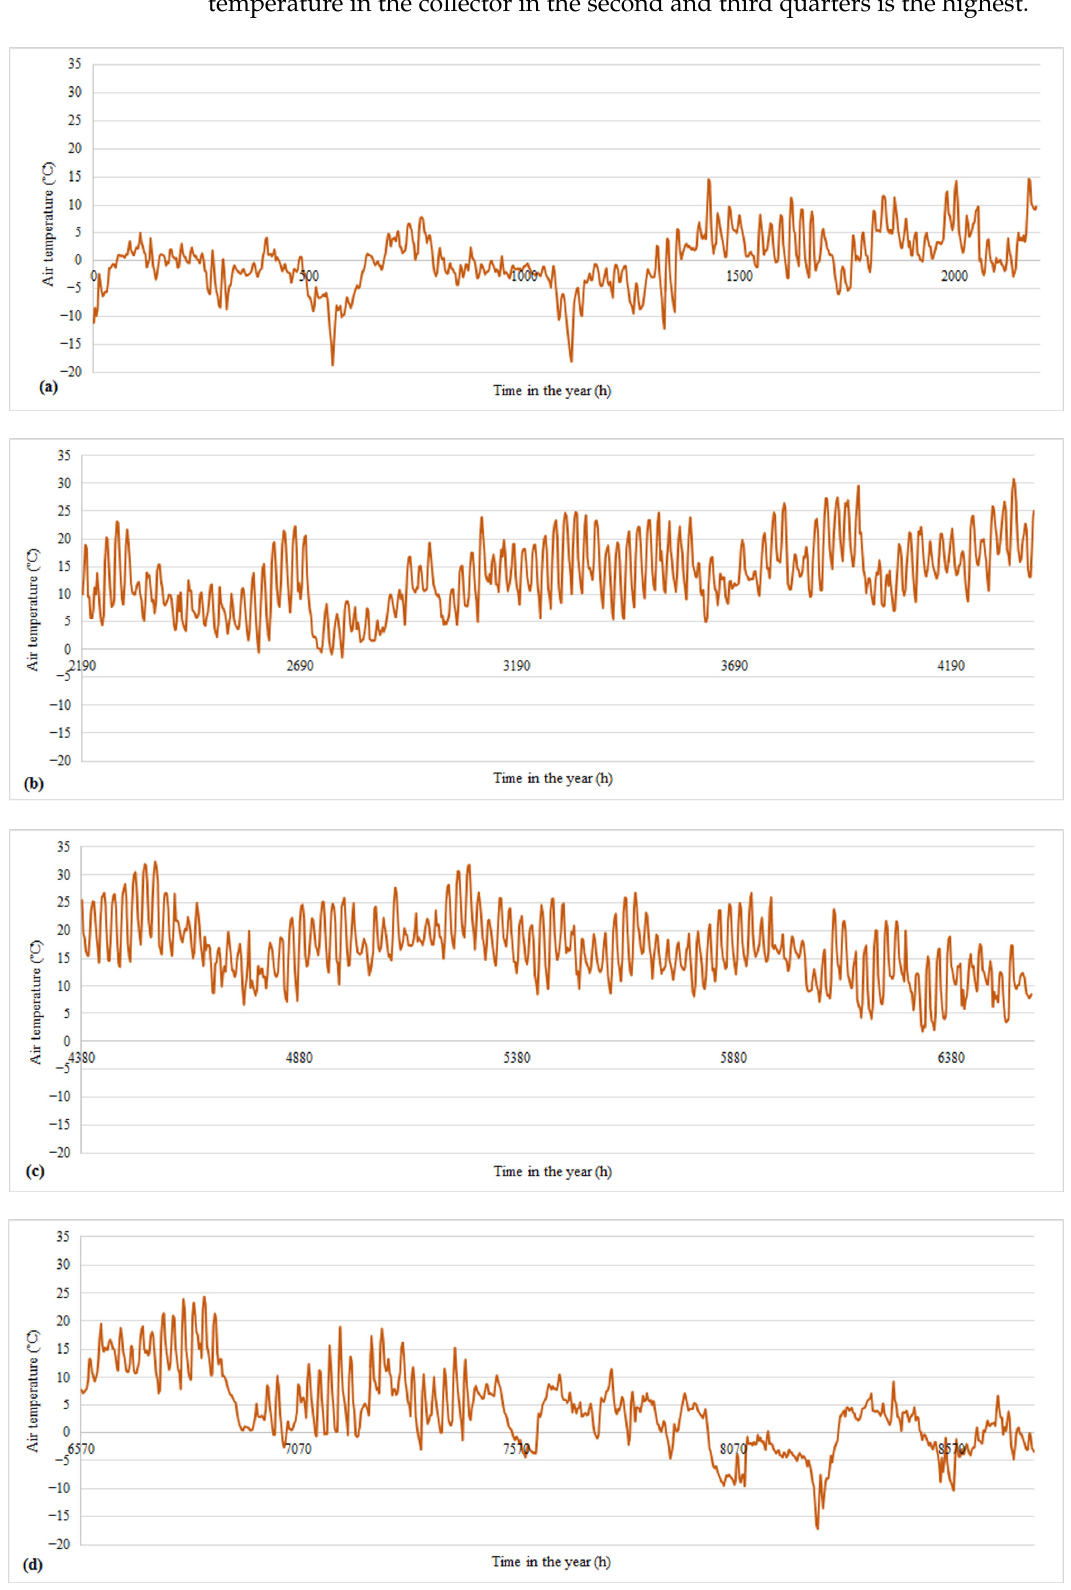
Figure 3. ( a – d ). Average air temperature in the collector in each quarter of the year.